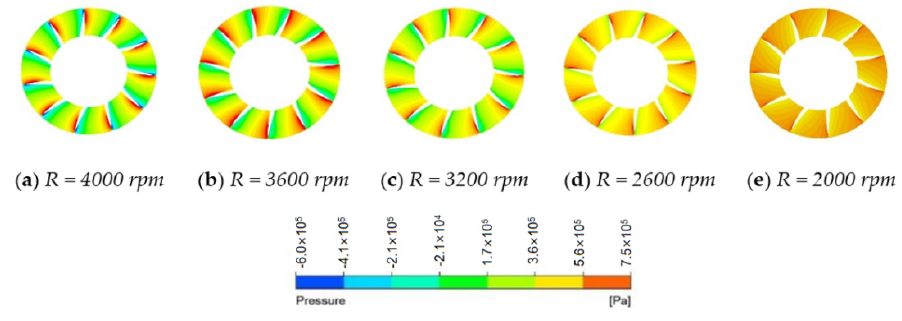
Figure 13. Water vapor volume fraction cloud of the rotor and stator blades.